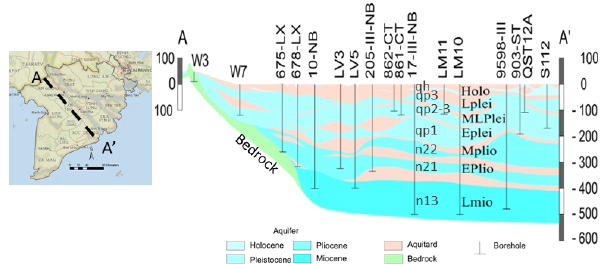
Figure 3. The setting and hydrogeological features, including aquifer names, of the Mekong Delta, Vietnam, with the loca- tions of the cross sections A–A (cid:48) (from Doan et al., 2016). Map copyright: © National Geographic, Esri, Garmin, HERE, UNEP- WCMC, USGS, NASA, ESA, METI, NCRAN, GEBCO,